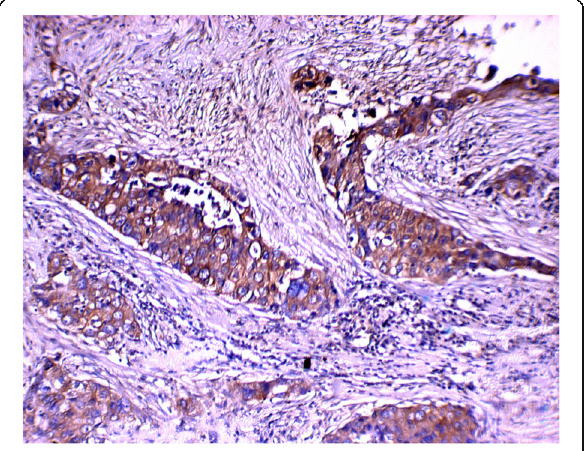
Fig. 4 Calpain II-positive staining was found in the cytoplasm of IDC tumor cells (×